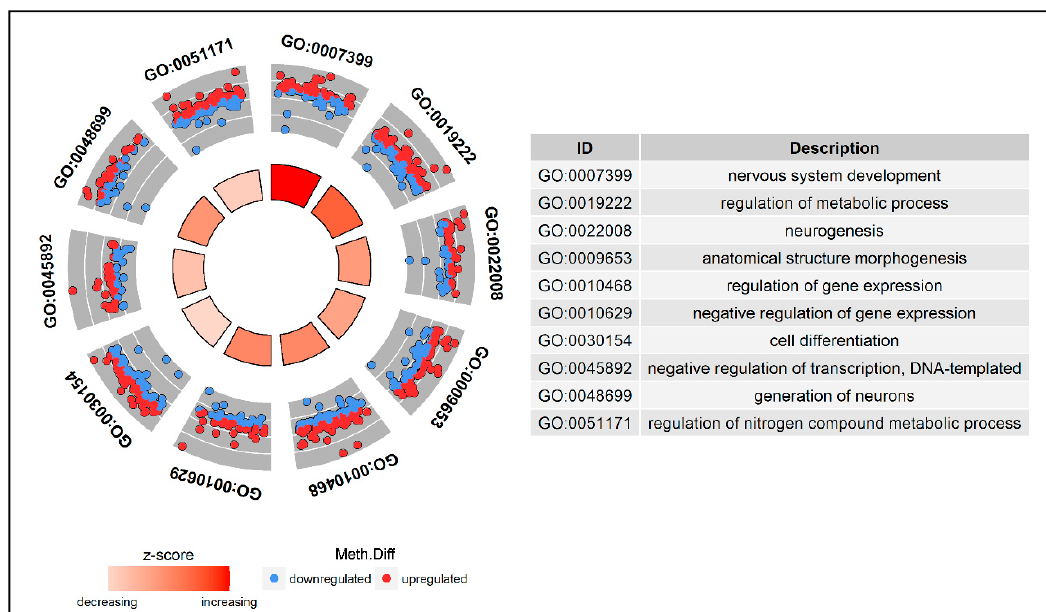
Figure 5. Gene Ontology (GO) circle plot for differentially methylated genes (DMGs). The inner ring is a bar plot where the height of the bar indicates the significance of the term ( q value), and color corresponds to the z-score. The outer wheel shows a scatter plot of methylation difference for each gene under the Gene Ontology(GO) terms. Red dots indicate hyper-methylated genes and blue dots show hypo-methylated genes.